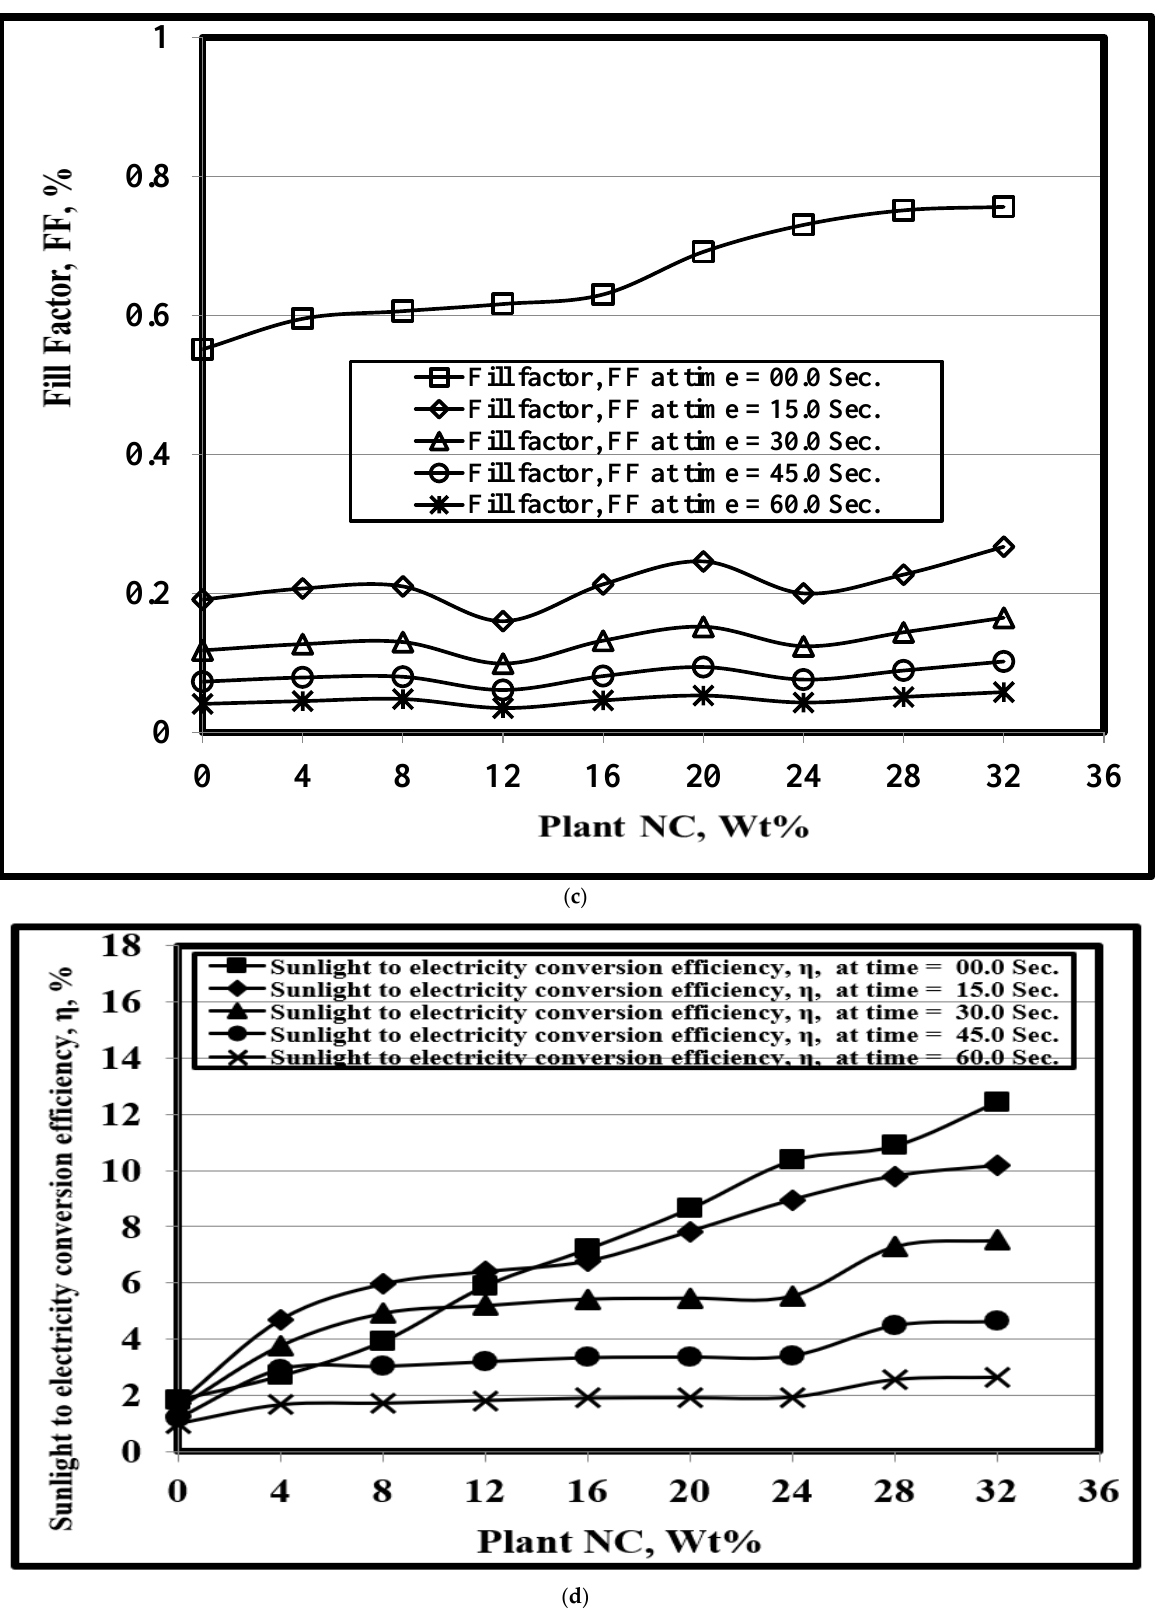
Figure 14. Effect of plant NC wt.% on ( a ) Short-circuit current, ( b ) open-circuit voltage, ( c ) fill factor, and ( d ) efficiency measured at 15 s intervals within 0 – 60 s.